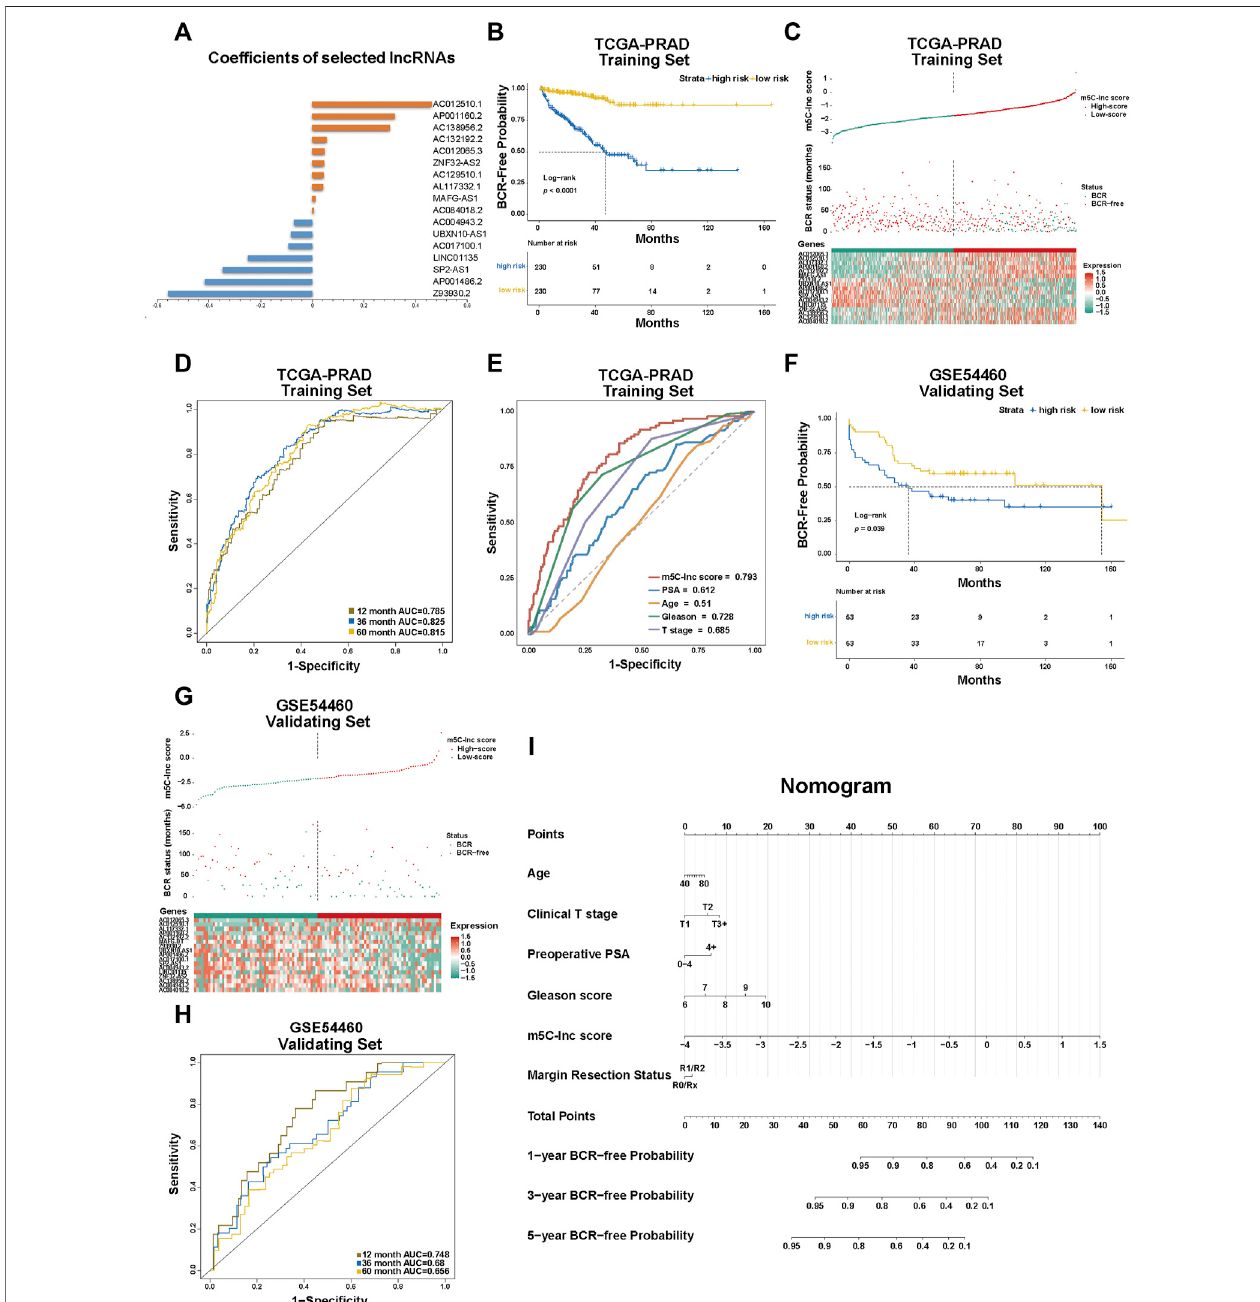
FIGURE 3 | Construction and validation of the m5C-Related lncRNA prognostic model in patients with prostate cancer. (A) The coef fi cients of the prognostic 17 m5C-relatedlncRNAscalculatedbyLASSOregressionanalysis. (B) Kaplan – MeiersurvivalanalysisshowsthatBCR-freetimeofpatientswithhighm5C-lncscoresis signi fi cantlyshorterthanofthosewithlowm5C-lncscores. (C) Theseparationoflowandhighm5C-lncscoresinpatientswithPCa;scatterplotdepictsthedistributionof BCR status between two groups divided by the median m5C-lnc score; the heatmap shows that patients with shorter BCR-free time displayed higher gene expression level of risk factors ( AP001160.2 , MAFG-AS1 , AL117332.1 , ZNF32-AS2 , AC129510.1 , AC012065.3 , AC012510.1 , AC084018.2 , AC132192.2 , and AC138956.2 ), while patients with longer BCR-free time displayed higher gene expression level of protective factors ( UBXN10-AS1 , AC017100.1 , AC004943.2 , SP2- AS1 , Z93930.2 , AP001486.2 , and LINC01135 ). (D) ROC curves illustrated the sensitivities of the prognostic m5C-lnc score model predicting 1-, 3- and 5-year BCR status. (E) ROC sensitivity comparison between m5C-lnc score and other clinical features including PSAlevel,age, Gleason score, and T stage. (F – H) The validation for the constructed prognostic model using GSE54460 dataset. (I) The nomogram containing the m5C-lnc score and other clinicopathological features for prognosis prediction.